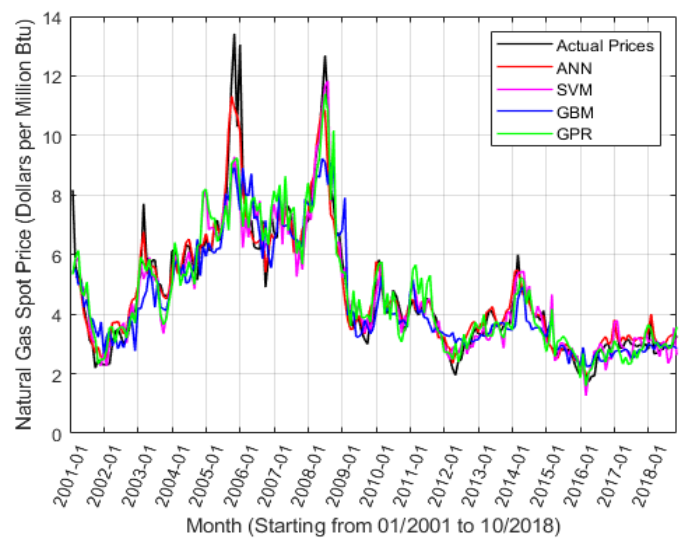
Figure 4. Visual Comparison of prediction results of four machine learning methods.